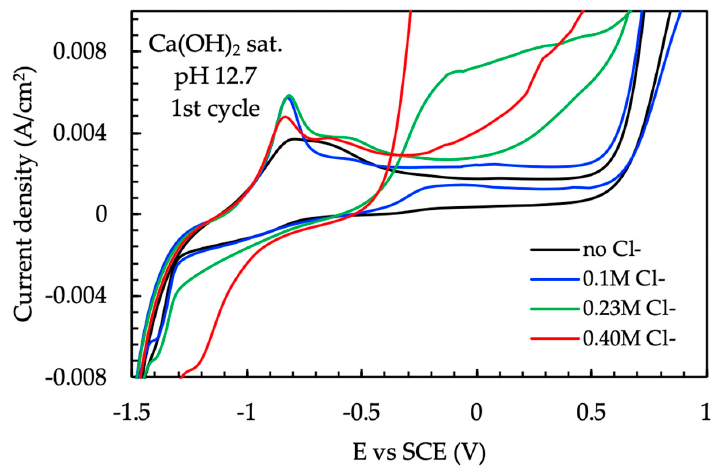
Figure 7. Effect of chloride ion concentration on the first cycle of the voltammetric curves of steel in saturated Ca(OH) 2 solution at pH 12.7 and tartrate ions in a concentration of 1 M.